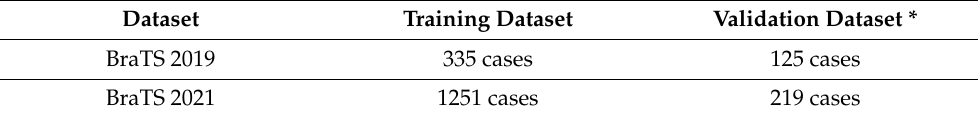
Table 1. A description of the datasets in this